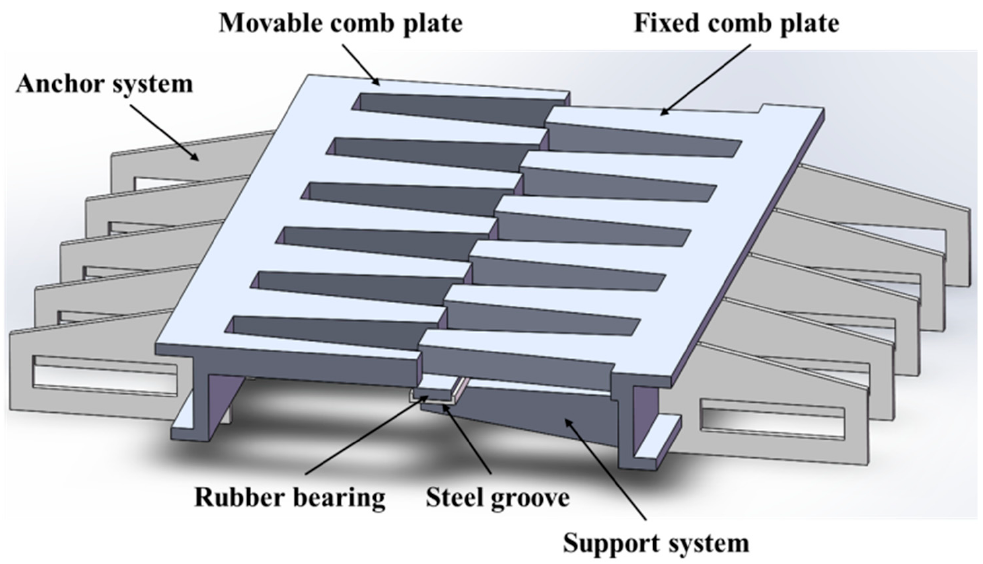
Figure 1. The sketch of a comb plate bridge expansion joint.